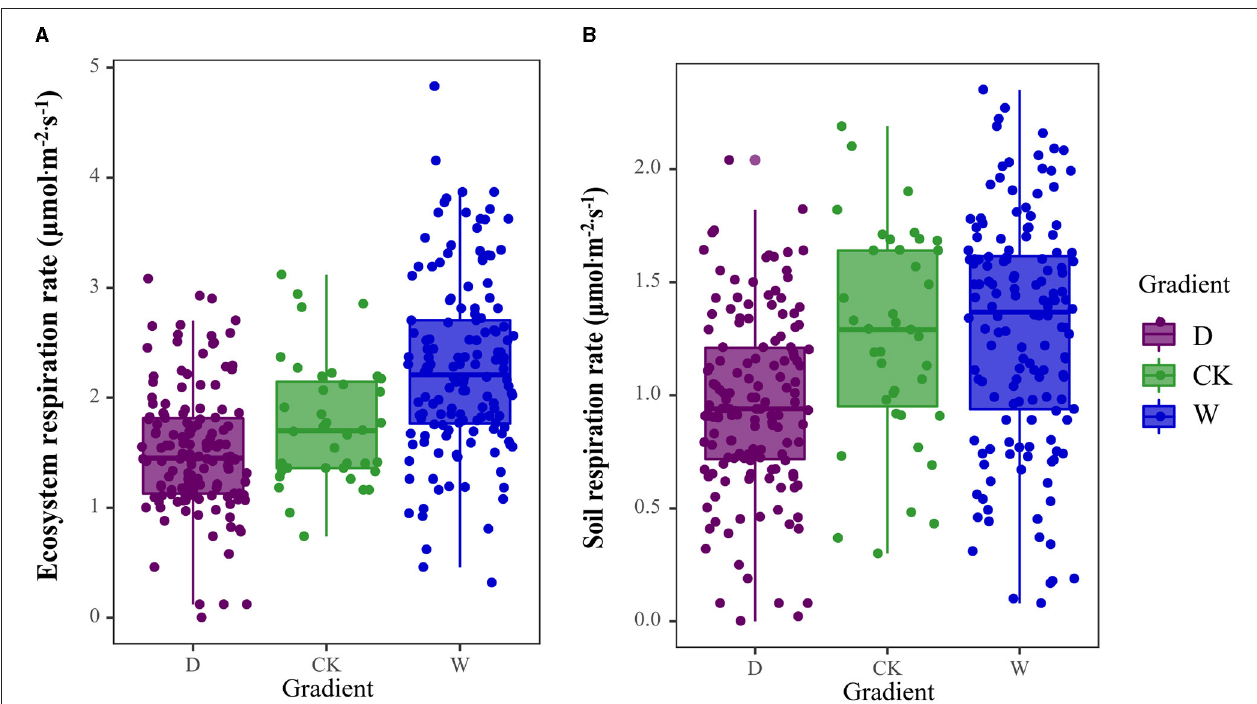
FIGURE 3 | Ecosystem respiration (A) and soil respiration (B) under the three precipitation treatments. D represents drought treatment; W represents wet treatment; CK represents ambient precipitation. Different letters (a, b, c, d, and e) indicate significant differences at p <